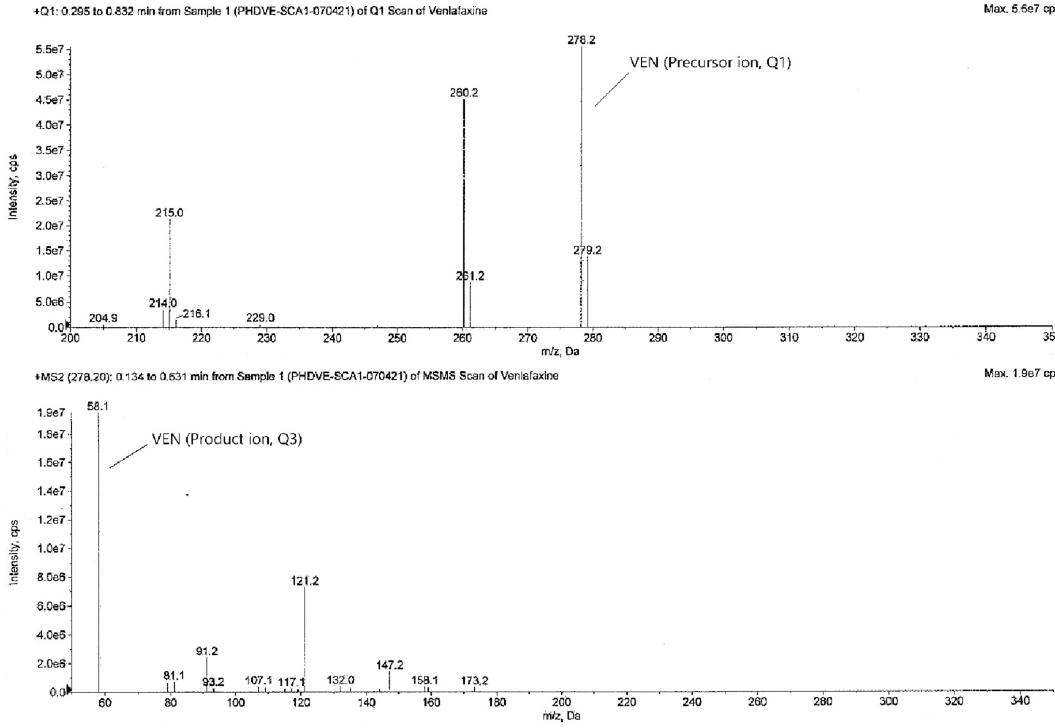
Figure 2. MRM mass spectra and fragmentation of venlafaxine.